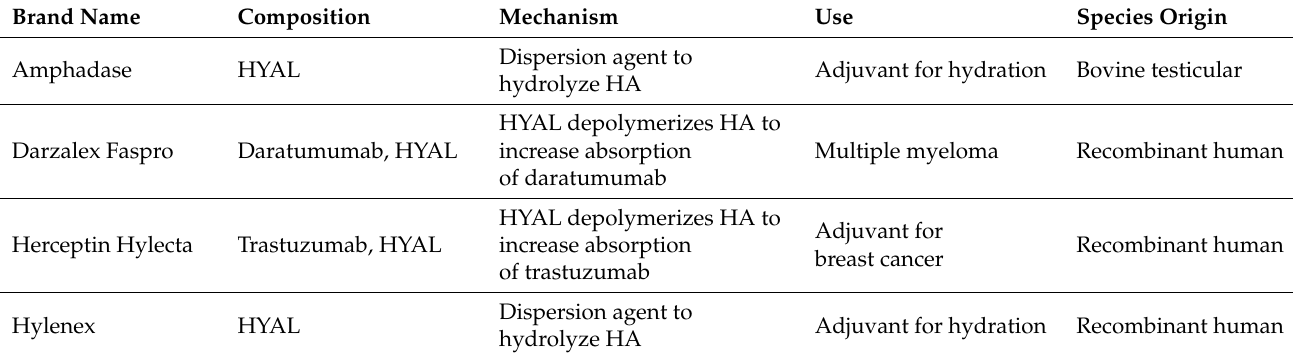
Table 3. List of approved drugs using HYALs. This table comprises a collection of drugs leveraging HYALs as either a primary or secondary component for the treatment of various conditions and diseases. All drugs are administered via subcutaneous injection, which benefits from HYALs degrading HA in the skin for increased absorption of the active ingredient. All listed drugs are approved by the